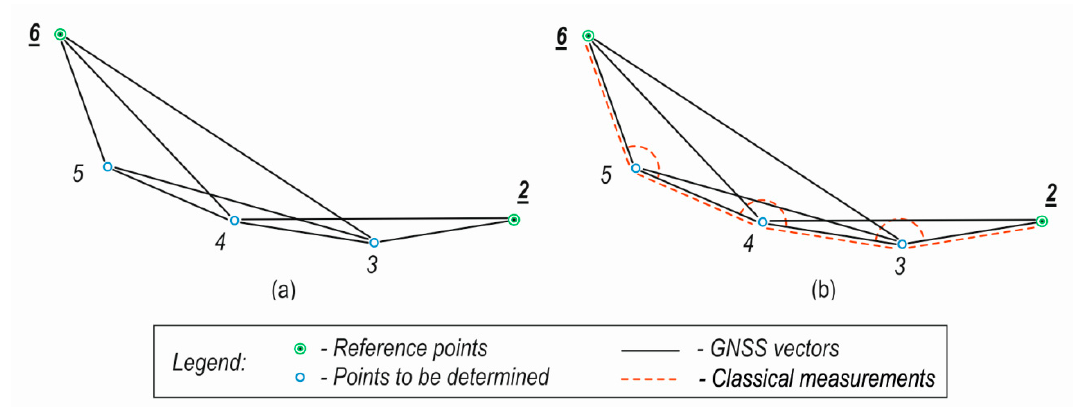
Figure 5. Diagram of the test networks: ( a ) GNSS vector network; ( b ) integrated network. Vectors between vertices of the network were measured with a static GNSS method (two receivers, survey duration 60 min). GNSS vectors were used in both test variants: GNSS network (Figure 5a) and integrated network (Figure 5b).